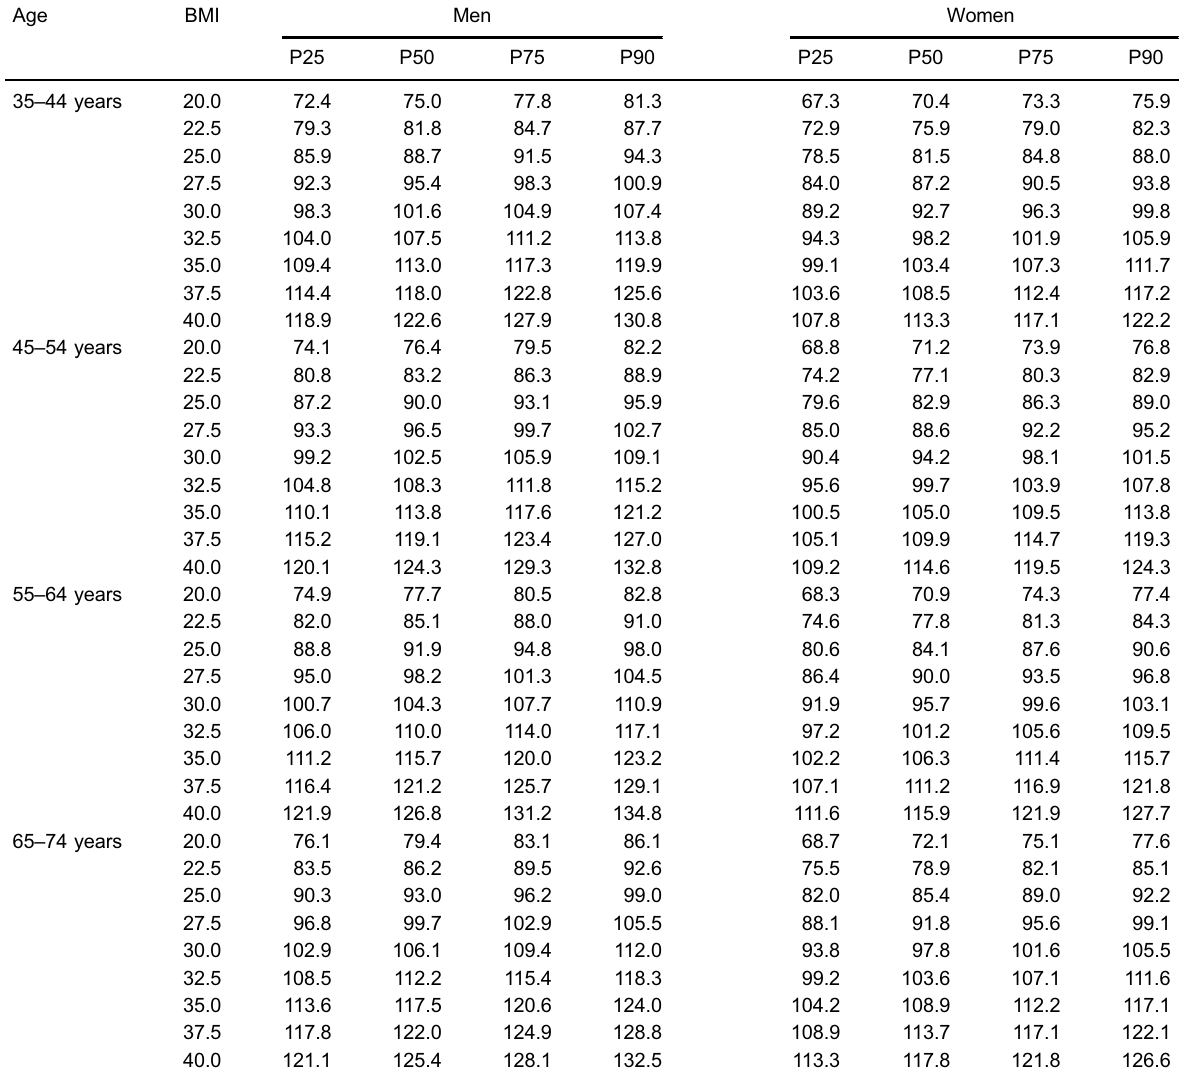
Table 3. Waist circumference predicted quantiles for sex, age, and body mass index (BMI). Age BMI